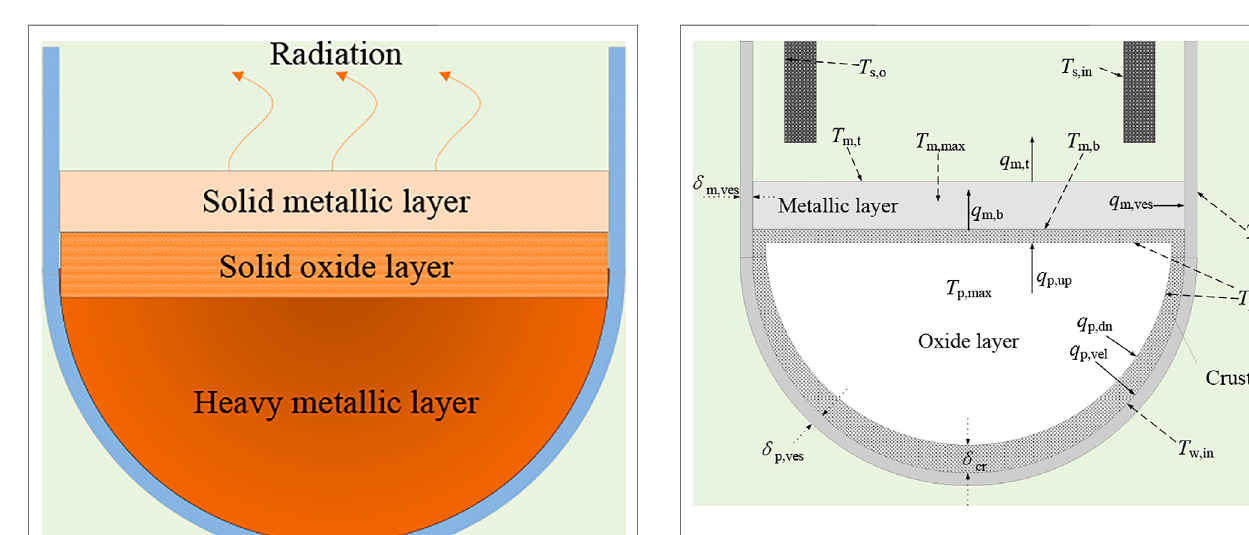
FIGURE 3 | Schematic diagram of two-layer molten pool with